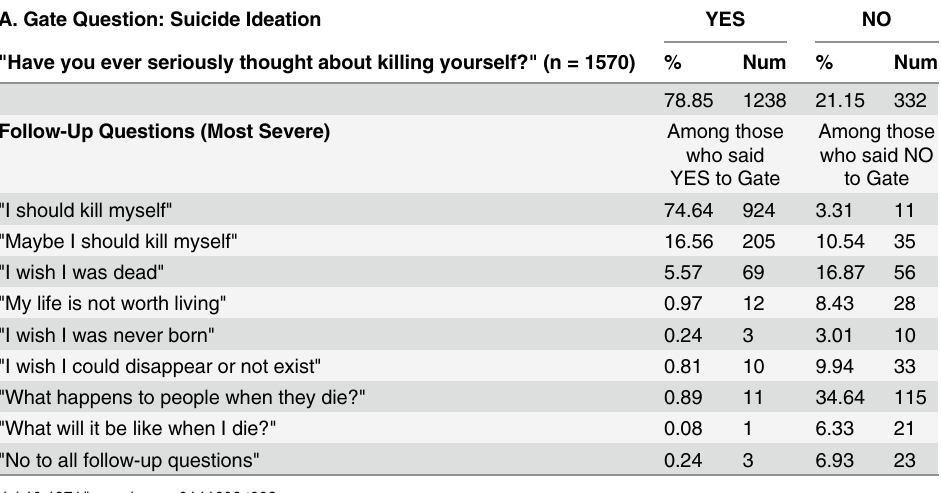
Table 2. Responses to gate and follow-up questions for suicide